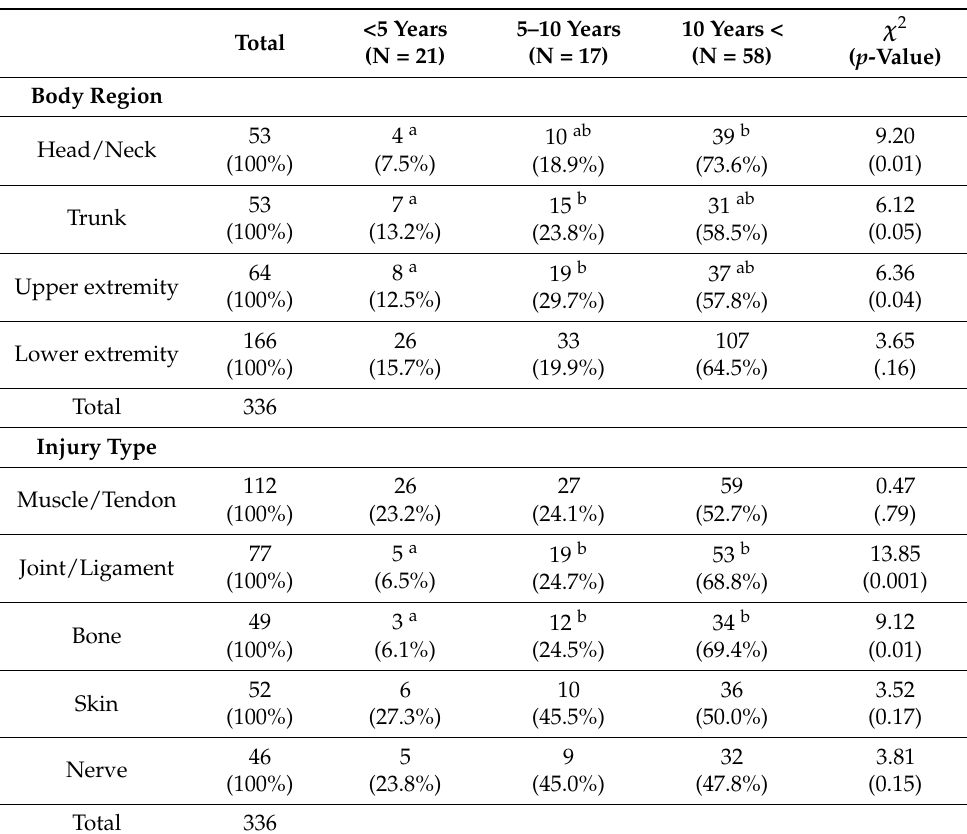
Table 3. Relationship between type and location of injury and years of